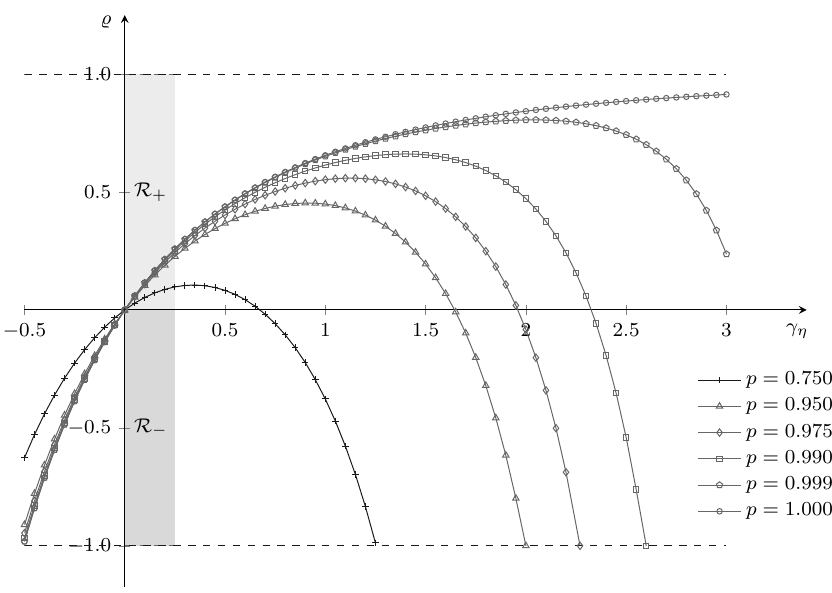
Φ ( γ η )) /φ ( γ η ) as a function of γ η for various value of p . Fig. 2 Plot of ( p Figure 2. Plot of ( p − Φ ( γ η )) / φ ( γ η ) as a function of γ η for various values of p −